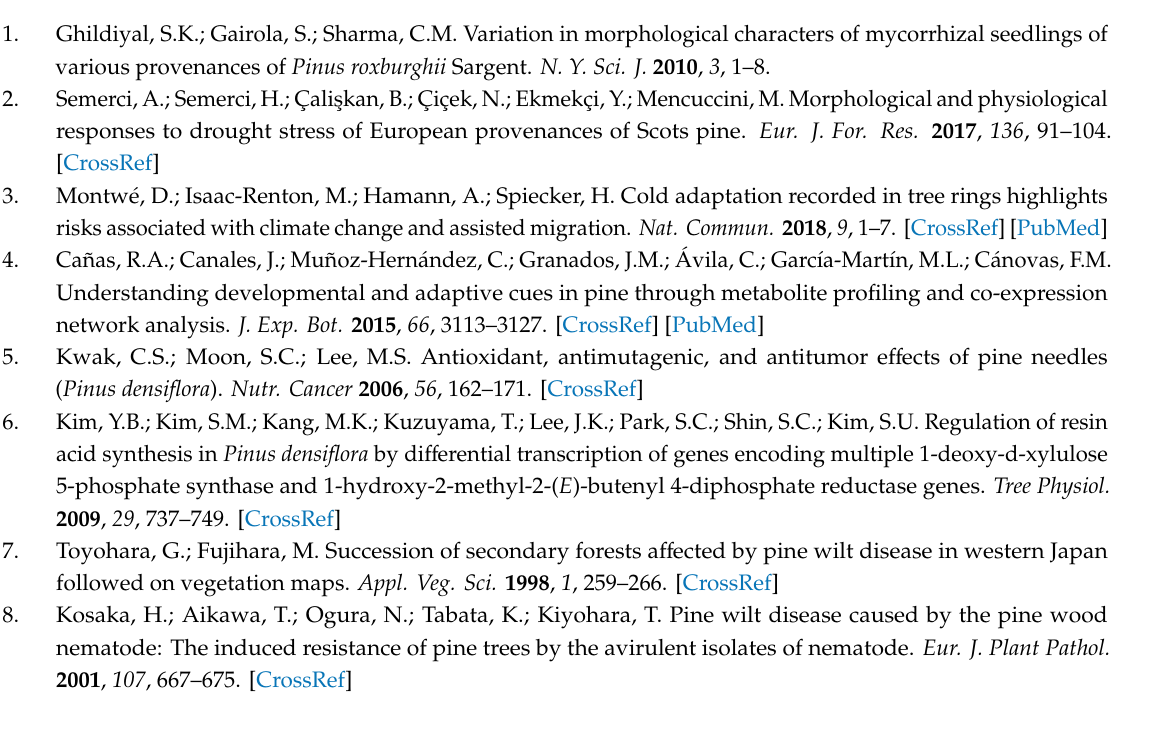
Figure S1: Quality assessment of raw reads in the FASTQ format, Figure S2: Pie charts showing functional categories according to BRITE hierarchy analysis, Figure S3: Verification of RNA-seq data by quantitative PCR (qPCR), Figure S4: Molecular networks showing expression changes in the photorespiration module within glyoxylate and dicarboxylate metabolism, Table S1: List of primers for quantitative real-time PCR analysis, Table S2: Overview of RNA-seq read processing, Table S3: List of non-redundant genes in reference genome for the genus Pinus , Table S4: Expression profiling of Pinus densiflora between resistance-inducing substances and untreated control, Table S5: Gene list associated with defence response to nematodes in MeSA-specific patterns. Author Contributions: Conceptualization, J.-C.K. and Y.-S.S.; methodology, J.P., H.W.J., H.J., J.K., and